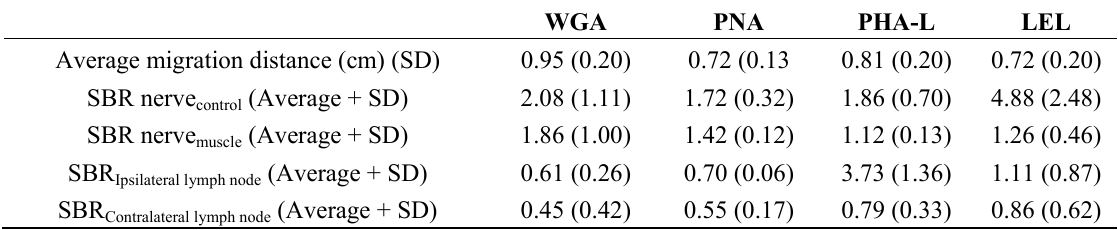
Table 2. Migration distance and signal to background ratios.